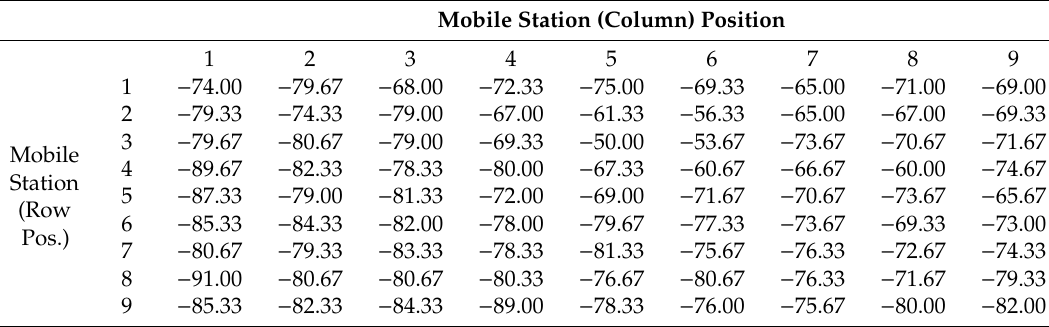
Table 3. Measured RSSI for MeS 3 (position 35: row 3, column